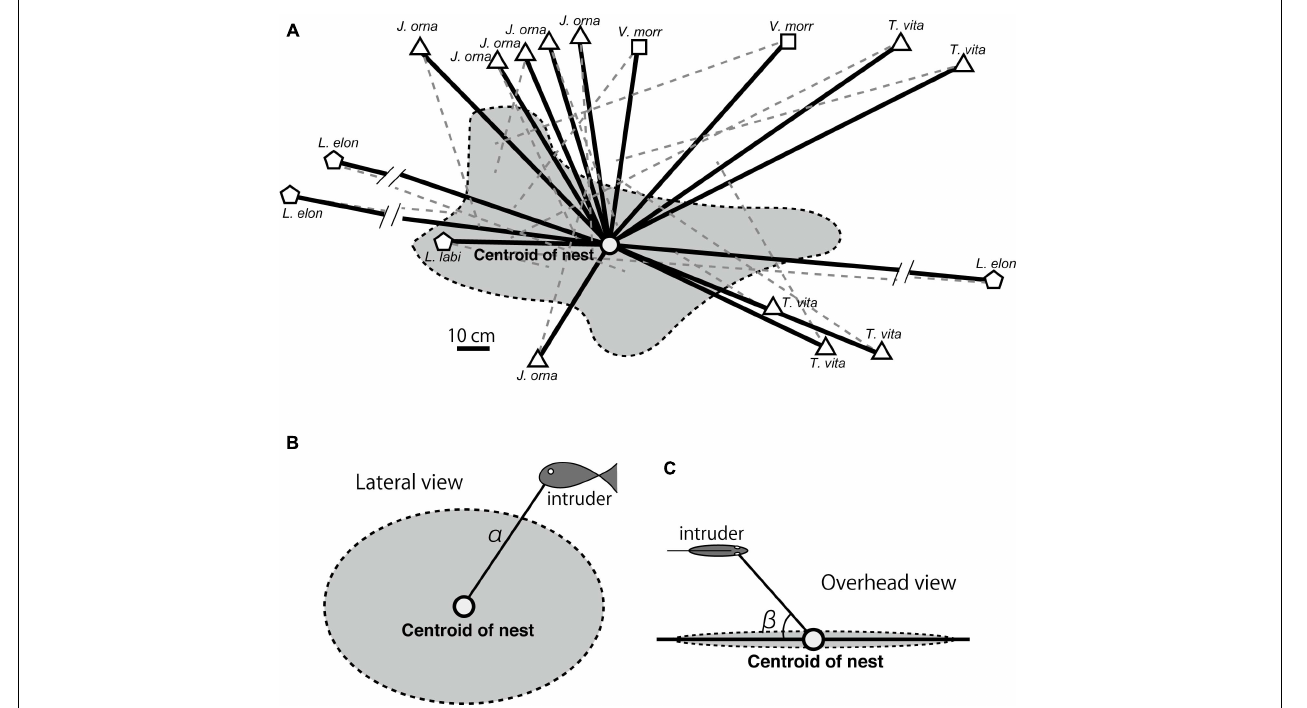
FIGURE 1 | Neolamprologus furcifer nest depiction. The nest area is shown in gray and the center of the nest is marked with a circle. Solid black lines show attack distance; broken gray lines represent the distance between the female and the intruder when the female began to behave aggressively. (A) Depiction of Neolamprologus furcifer female brood defense behavior against Julidochromis ornatus ; Variabilichromis moori ; Telmatochromis vittatus ; Lepidiolamprologus elongatus ; Lobochilotus labiatus . (B) Depictions of the lateral and (C) overhead views of the nest recorded using video cameras. The attack distances were estimated using the following formula: attack distance = α /(cos β